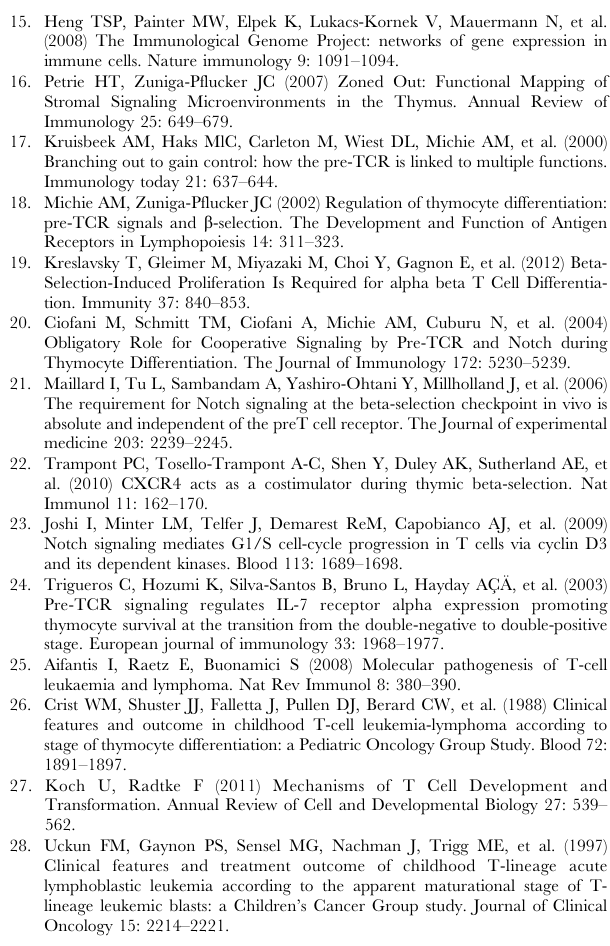
Figure S6 Shcbp1 expression specifically in T cells contributes to EAE disease severity. (A-B) Survival curves and clinical scores of Rag1 2 / 2 mice after EAE induction one-week post transfer with CD4 + T cells isolated from either Shcbp1 2 / 2 or Shcbp1 + / + mice (n =7, 8). (C) Clinical scores of Lck -Cre + / Shcbp1 wt/wt and Lck - Cre + / Shcbp1 fl/fl mice after EAE induction (n= 4,8). (D) RT-PCR for Shcbp1 in naı¨ve or ex vivo T H 17 or T H 1 skewed CD4 + T cells (normalized to HPRT and unstimulated CD4 + T cells) (n= 2 mice of each genotype) (E-F) Intracellular staining for IL17-A or IFN c in CD4 + T cells from Shcbp1 + / + and Shcbp1 2 / 2 mice after skewing (representative of n= 4 experiments with n= 4 mice of each genotype). (G) Cell surface staining for CD11b, CD45, and CD4 in mononuclear cells isolated from healthy controls or Shcbp1 + / + or Shcbp1 2 / 2 mice 28 days after EAE induction. (TIF)